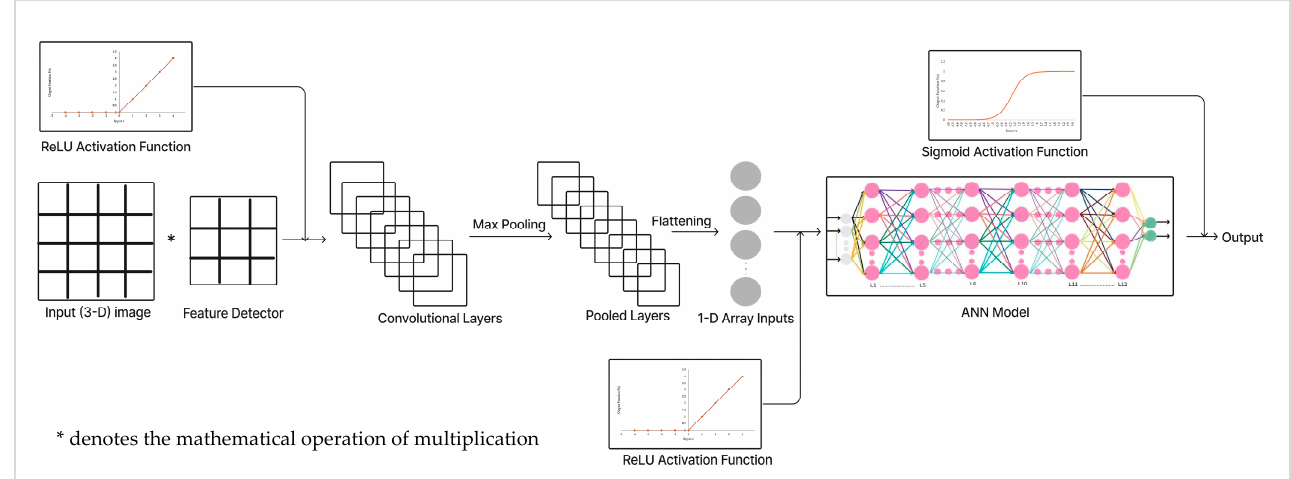
Figure 4. Proposed CNN architecture.